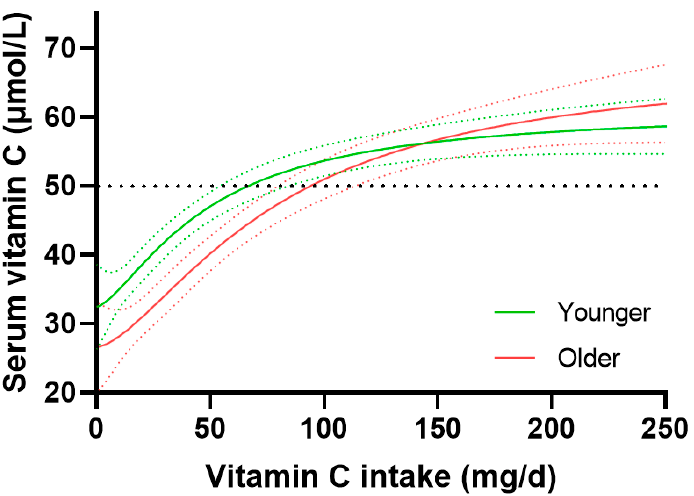
Figure 5. Vitamin C dose-response relationship relative to age. Younger age tertile 18–36 years ( n = 942) vs. older age tertile 59–80+ years ( n = 944). Sigmoidal (four parameter logistic) curves were fitted to the dose-concentration data with asymmetrical 95% confidence intervals indicated. Dashed line indicates 50 µ mol/L serum vitamin C, which is considered ‘adequate’.